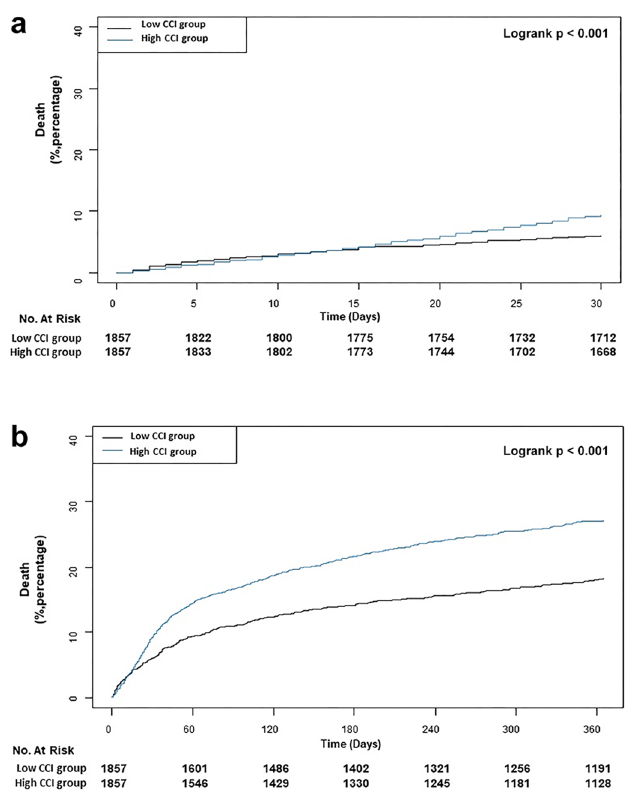
Figure 2. Kaplan–Meier curves of ( a ) 30-day mortality and ( b ) One-year mortality for the propensity score matched